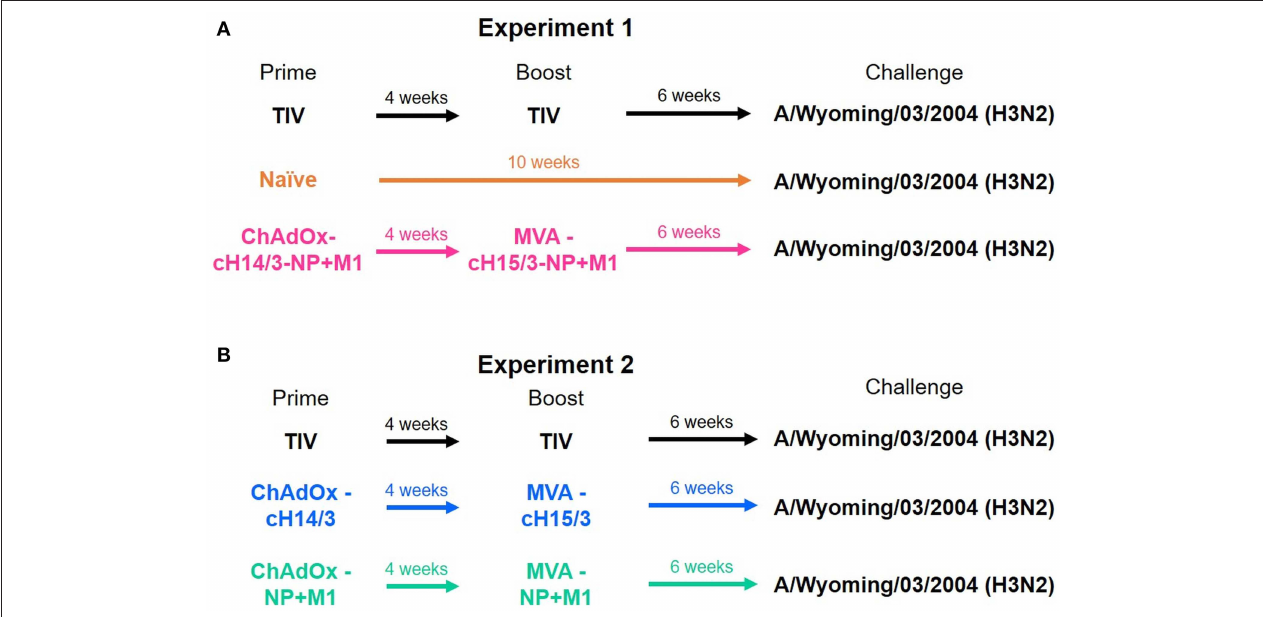
FIGURE 1 | Ferret vaccination regime. In the first experiment ferrets were either prime-boosted with the virus-matched TIV, primed with ChAdOx1-cH14/3-NP + M1 and boosted 4 weeks later with MVA-cH15/3-NP + M1 or were naïve (A) . In the second experiment ferrets were either prime-boosted with the virus-matched TIV, primed with ChAdOx1-cH14/3 and boosted 4 weeks later with MVA-cH15/3 or primed with ChAdOx1-NP + M1 and boosted with MVA-NP + M1 (B) . The study was split into two experiments due to space limitations. The TIV groups served as bridging groups.